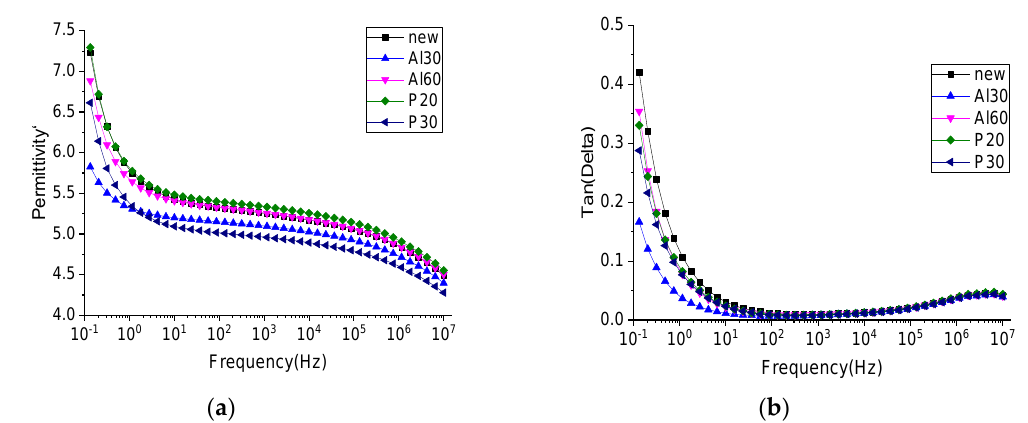
Figure 13. Frequency dielectric spectrum ( a ) and dielectric loss spectra ( b ) of the insulating pressboard with single film.